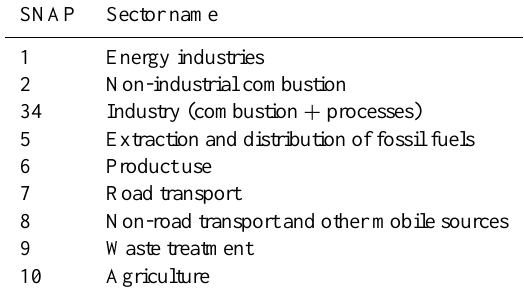
Table 1. Explanation of the SNAP source categories (SNAP 3 and SNAP 4 are merged to SNAP